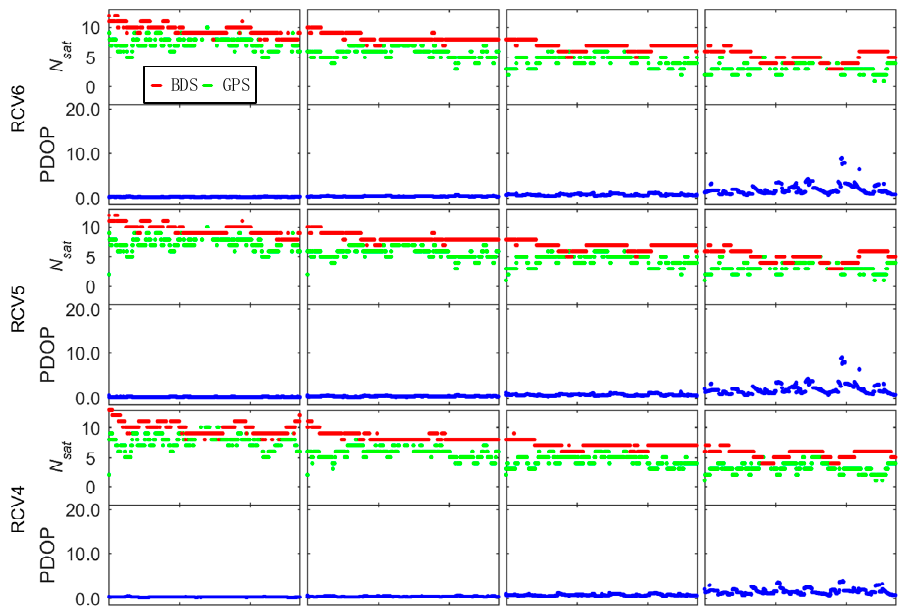
Figure 6. PDOP and satellite number with different cutoff elevation angles. N sat represents the number of visible satellites, and PDOP represents the position dilution of precision of BDS and GPS satellites. Note that eastern errors are represented by green points, northern errors are represented by red points, and vertical errors are represented by blue points. The rows from top to bottom are satellite number and the PDOP of RC6, RC5, and RC4. The columns from left to right correspond to the different cutoff elevation angles (15 ◦ , 25 ◦ , 35 ◦ , and 45 ◦ ). Table 8. Error root mean square (RMS) of positioning results with different cutoff elevation angles (m). Table 7. Mean of the PDOP and satellite number with different cutoff elevation angles. RC Pairs